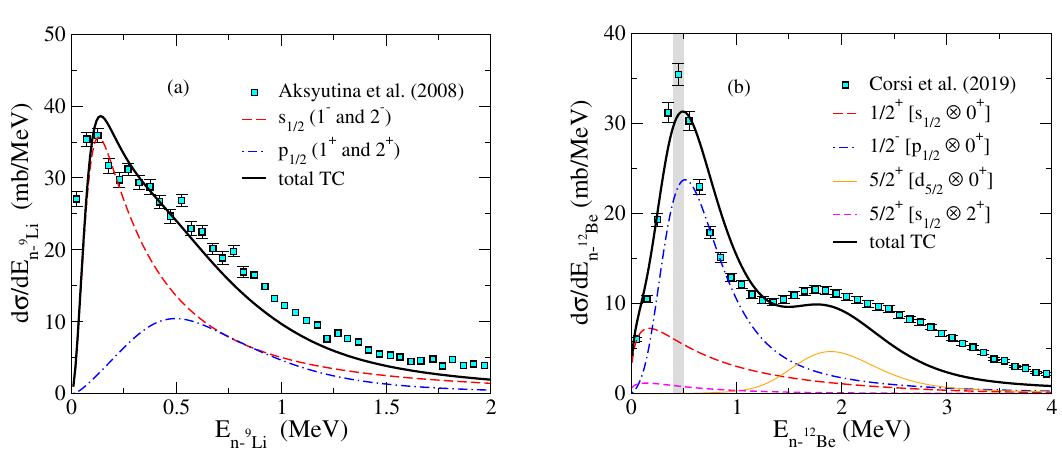
Figure 2. Relative-energy spectra of a) 10 Li and b) 13 Be after one-neutron knockout from 11 Li and 13 Be, respectively, and compared with the data of Refs. [12, 14] after convolution with the experimental resolution. The shaded area in the right panel is the region integrated to generate the momentum distribution in Fig.